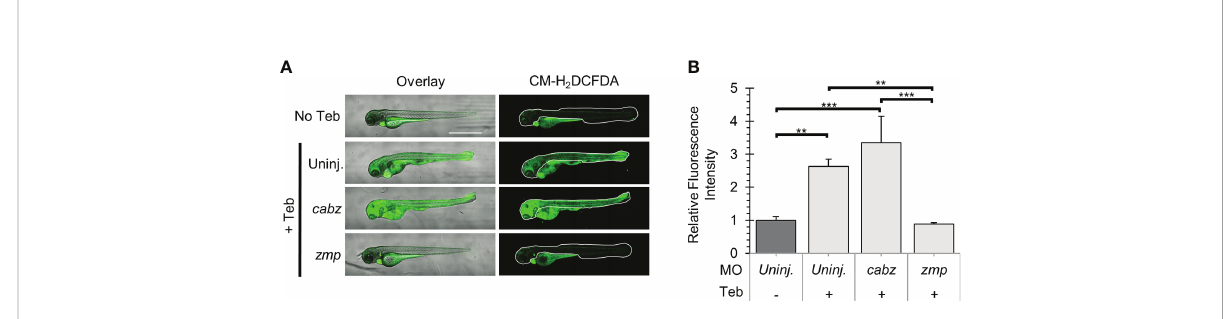
FIGURE 7 Analysis of Reactive Oxygen Species in Il-1 b -induced in fl ammation. (A) Representative confocal images of ubb:Gal4-EcR , uas:Il b mat larvae treated with CM-H 2 DCFDA. Shown here are the overlay of bright fi eld and CM-H 2 DCFDA fl uorescence (left panels) and CM-H 2 DCFDA fl uorescence only (right panels). Fluorescence signal was quanti fi ed from the region of interest outlined with a white border in the CM- H 2 DCFDA images. (B) Relative Fluorescence Intensity (RFI) was quanti fi ed using FIJI ‘ mean grey value ’ measurement. All mean RFIs were normalized to uninjected No Teb mean values. Error Bars are +1 standard deviation. Asterisks indicate signi fi cant differences **p < 0.01 ***p < 0.001 by one-way ANOVA followed by Tukey ’ s HSD Test. Scale bar in (A) is 1